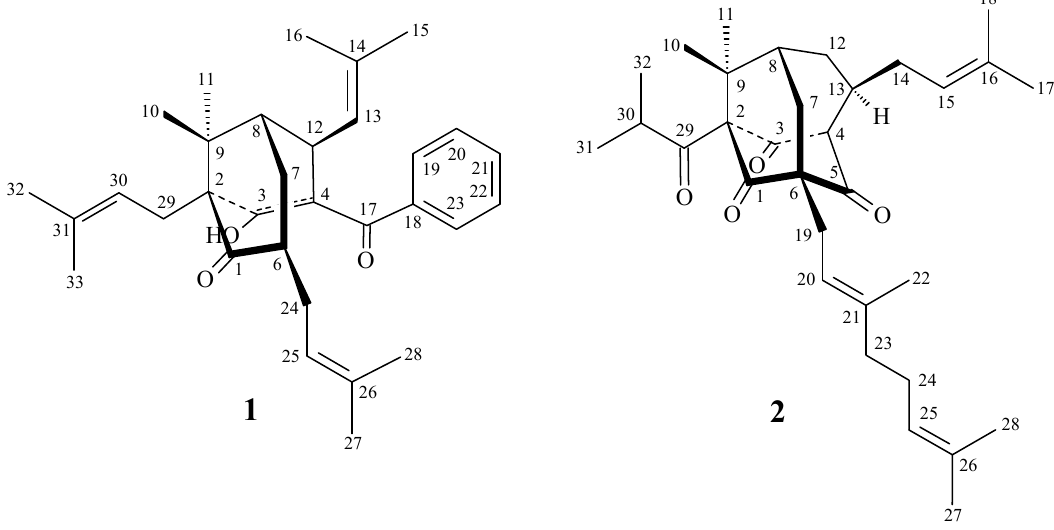
Figure 1. The chemical structures of new compounds 1 and 2 isolated from H. sampsonii .